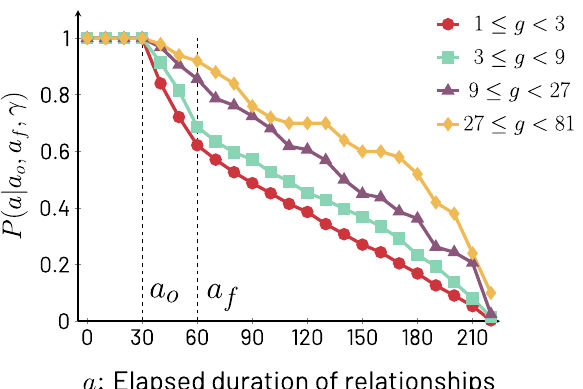
Figure 4. Survival probability P ( a | a o , a f , γ) of transient alters to duration of at least a for different bins γ of amount of mobile phone calls between a o = 30 and a f = 60 days. We use the combined data for UK, Italy and US, and therefore, we only look at relationships active for ℓ < L US = 220 days or less, in order to include data for all three cohorts. The bins represented by γ as the exponent in 3 γ ≤ g < 3 γ + 1 are γ = 0, 1, 2, 3 . As γ increases, the probability of survival also increases, i.e. for γ ′ > γ , P ( a | a o , a f , γ ′ ) > P ( a | a o , a f , γ) which is equivalent to saying that P ( a | a o , a f , γ) decays more slowly in terms of a as γ increases. See Supplementary Information, Fig. S19, for various combinations of a o , a f